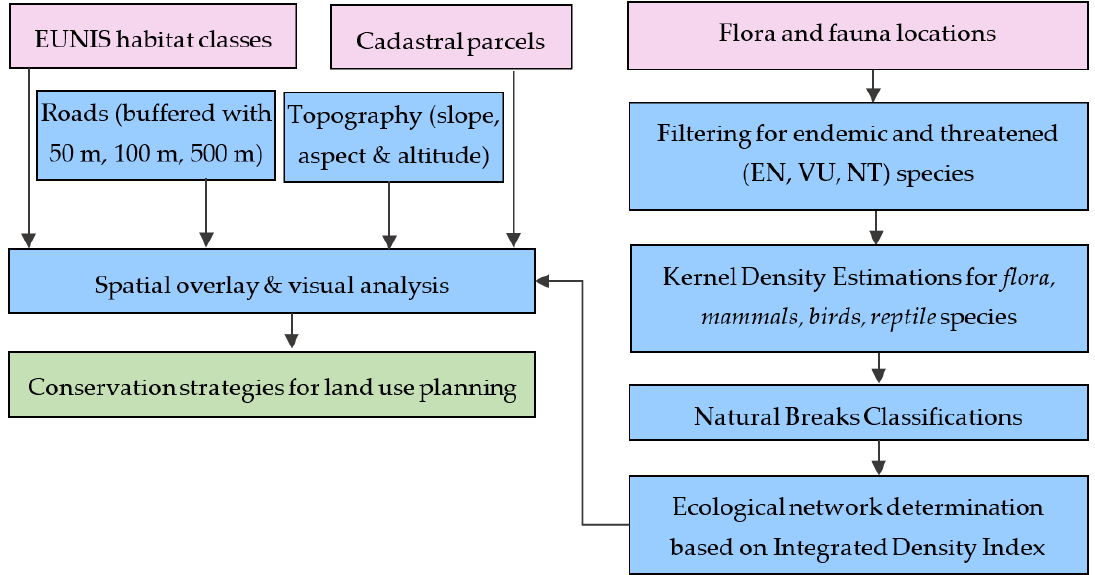
Figure 4. Methodological framework for the Kas-Kekova PA.